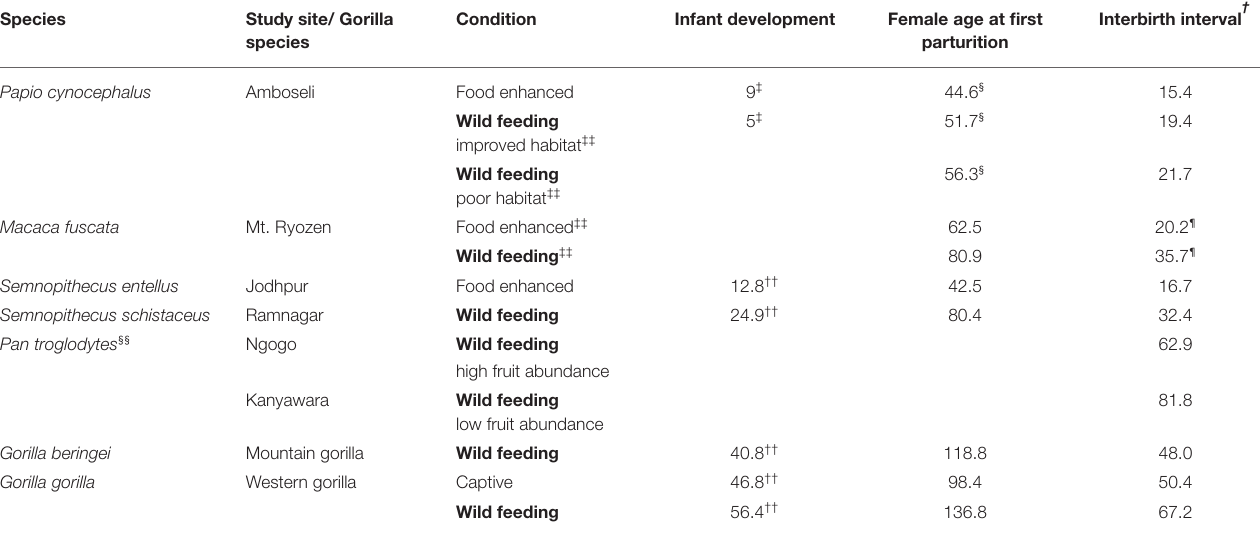
TABLE 1 | Examples of phenotypic plasticity in primate life history (mean values in months, except when noted).